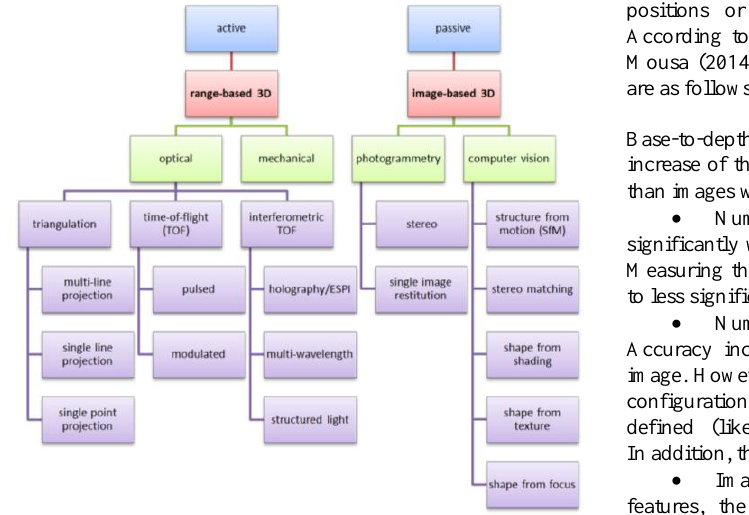
Figure 3: Division of 3D modelling methods (Remondino, El-Hakim, 2006).